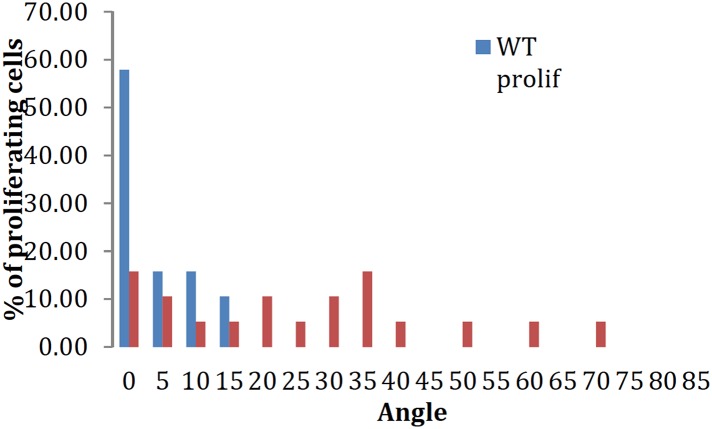
DOI:
http://dx.doi.org/10.7554/eLife.08077.011